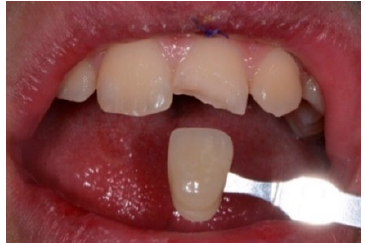
Figure 7. Color matching with Vita 3D Master scale.